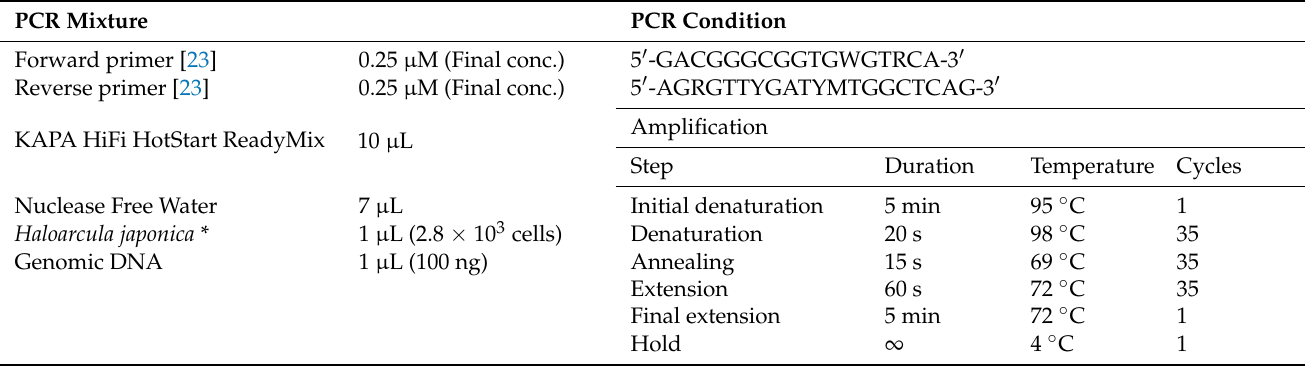
Table 1. PCR mixture (one sample) and PCR condition for amplification of V1–V9 region of the 16S rRNA